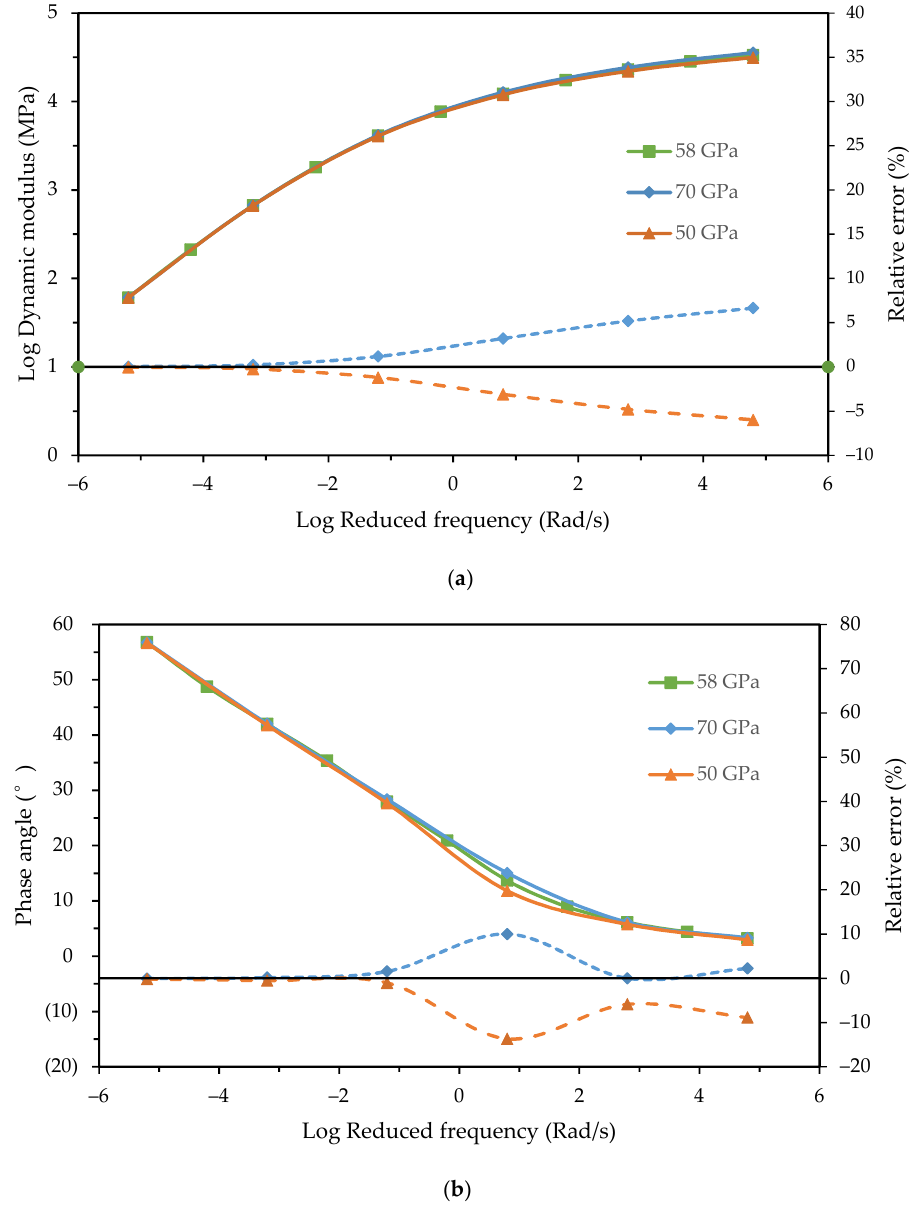
Figure 10. Influence of the elastic modulus of aggregate: ( a ) Dynamic modulus; and ( b ) phase angle. It shows that the elastic modulus of aggregate had an effect on both the dynamic modulus and phase angle. As the frequency increased, the effect of the modulus on the dynamic modulus monotonically increased while the relative error of the phase angles had fluctuated and reached a peak at 1 Rad/s. The relative error of the dynamic modulus test was less than that of the phase angle. It indicates that the elastic modulus of aggregate had a greater effect on the phase angle.